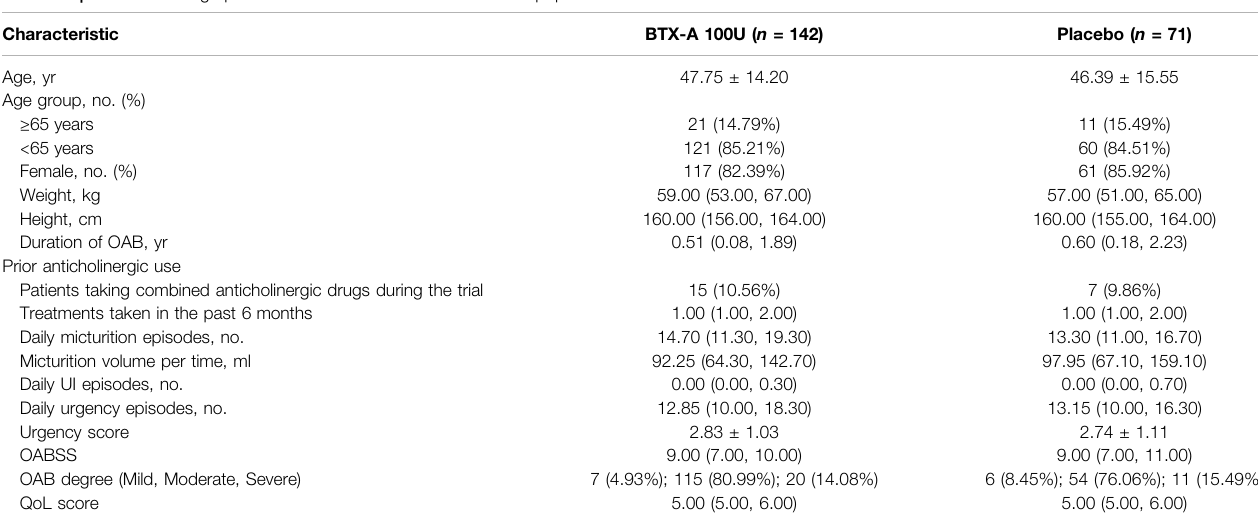
TABLE 1 | Baseline demographics and disease characteristics of FAS